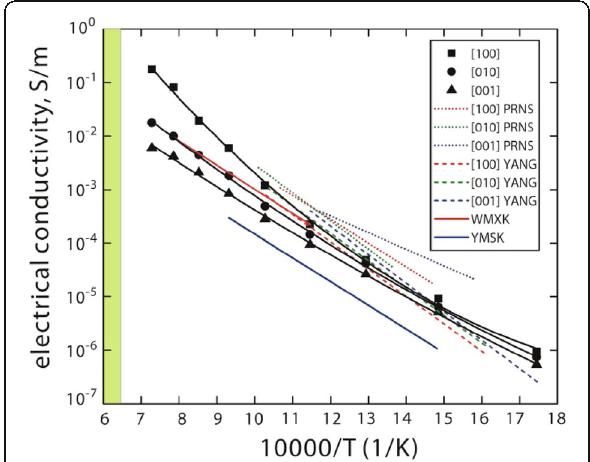
Fig. 8 Electrical conductivity of olivine single crystals determined under a broad temperature range (from Dai and Karato 2014b). Water content is 460 ppm wt (Paterson calibration). This value is chosen to minimize the extrapolation. YMSK: Yoshino et al. (2009). PRNS: Poe et al. (2010). WMSK: Wang et al. (2006). Yang: Yang (2012). Anisotropy is weak at low temperature but increases at high temperature. Low temperature results agree reasonably well with other results except for Yoshino et al. (2009). Yoshino et al. (2009) shows data on water content after the measurements using two different units in their Table 1 that do not match each other by a factor of 10. I used the one that they recommend (by personal